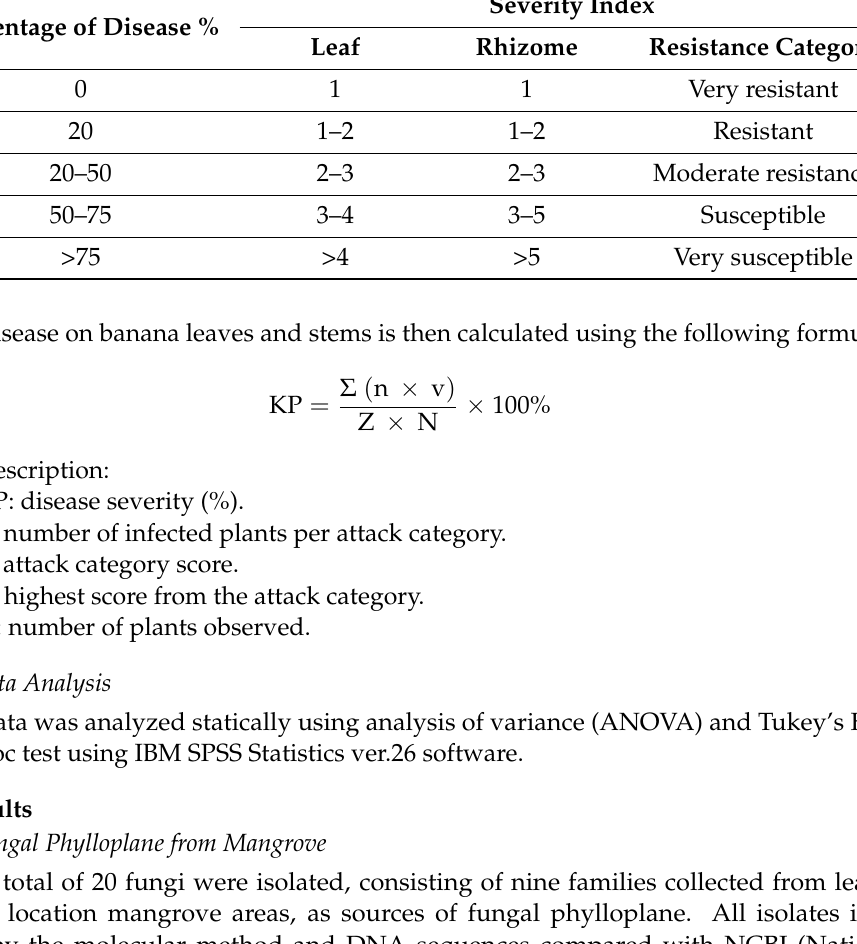
Table 1. Value of disease severity based on Emilda et al. (2020) [16]. Percentage of Disease